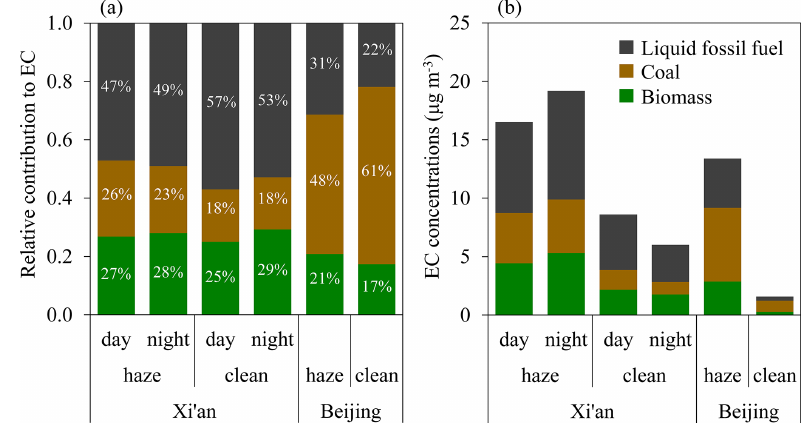
Figure 4. (a) Fractional contributions of three combustion sources to EC during haze and clean periods in Xi’an and Beijing. (b) EC concentrations (µgm − 3 ) from each combustion source. The data are presented in Tables S5 and S6.